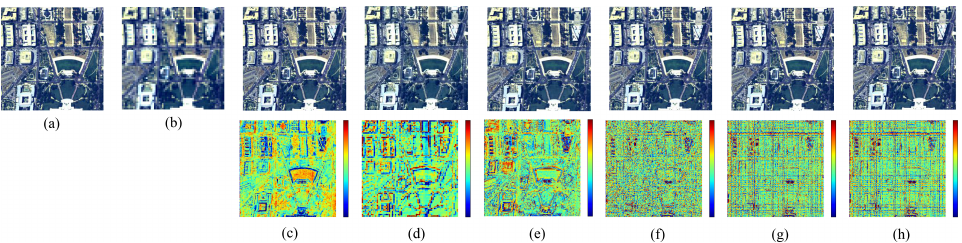
Figure 10. Comparison of fusion results on the Washington DC dataset. ( a ) Reference Image; ( b ) LR-HSI; ( c ) CNMF; ( d ) HySure; ( e ) NLSTF; ( f ) CSTF; ( g ) UTV-HSISR; ( h )